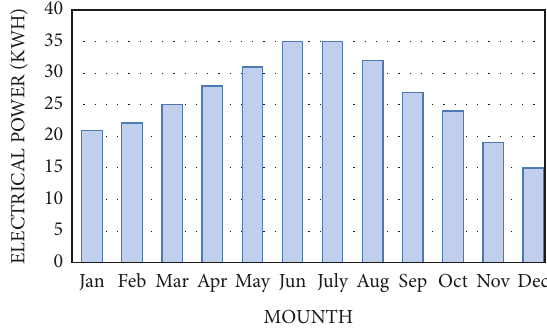
Figure 5: Total electricity generated by the organic Rankin cycle per